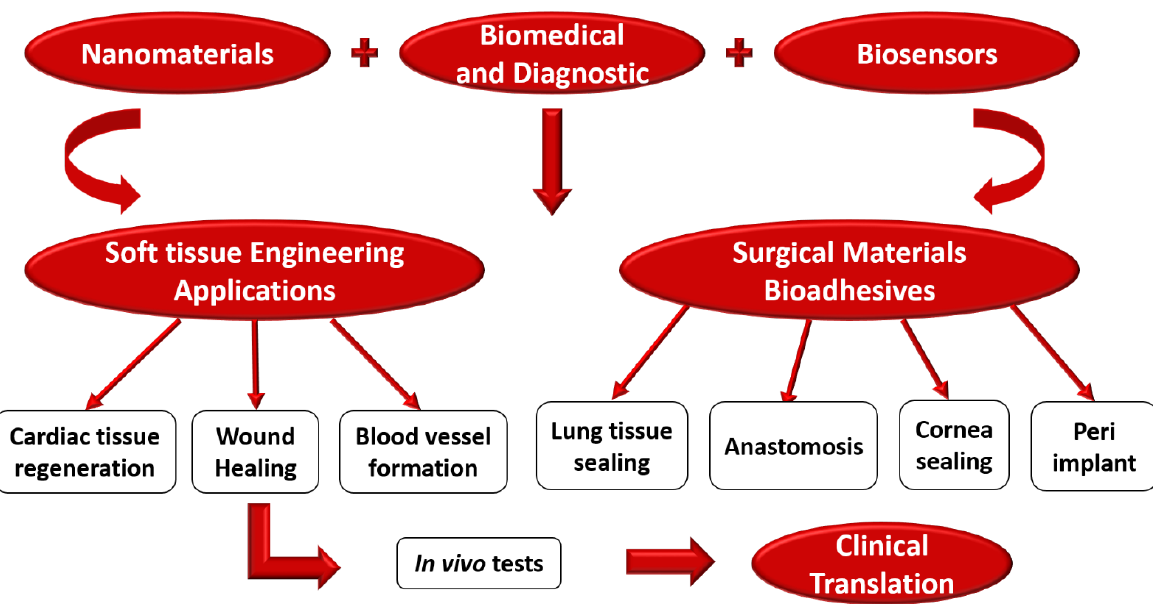
Figure 7. Shows the process of nanobiosensors used for various biomedical and diagnostics appli- cations.